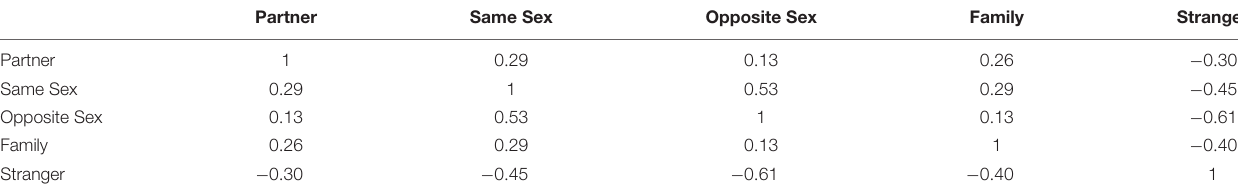
TABLE 3 | Correlations between Touch Avoidance Questionnaire (TAQ) factors. Partner Same Sex Opposite Sex Family Stranger